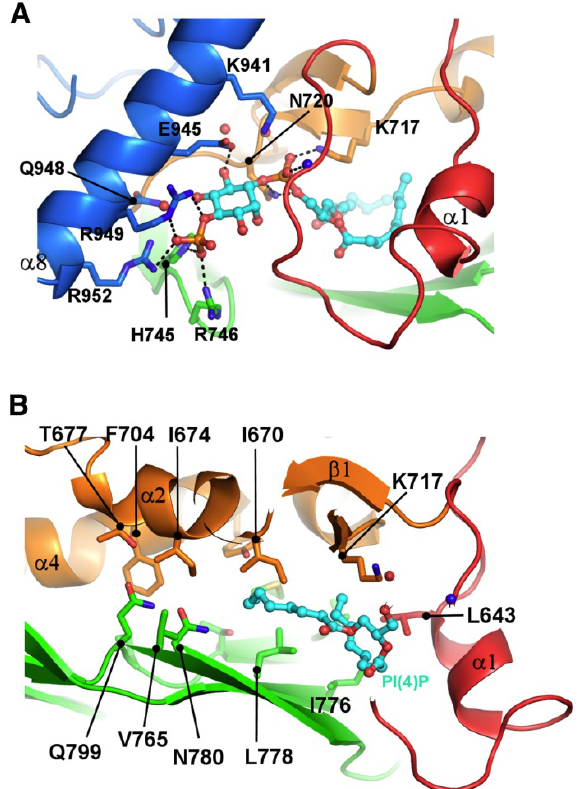
Figure 2. The yeast Osh3p ORD binds phosphatidylinositol-4-phosphate. ( A ) Binding of PI4P in the ORD. The two fatty acyl chains are inserted in the central hydrophobic tunnel, and the phosphoinositol head group is accommodated in a shallow basic cleft at the tunnel entrance. ( B ) The hydrophobic tunnel. The amino acid residues composing the wall of the tunnel are shown as ball-and-stick models. Reprinted with permission from Tong et al . [58] Copyright (2013) Elsevier